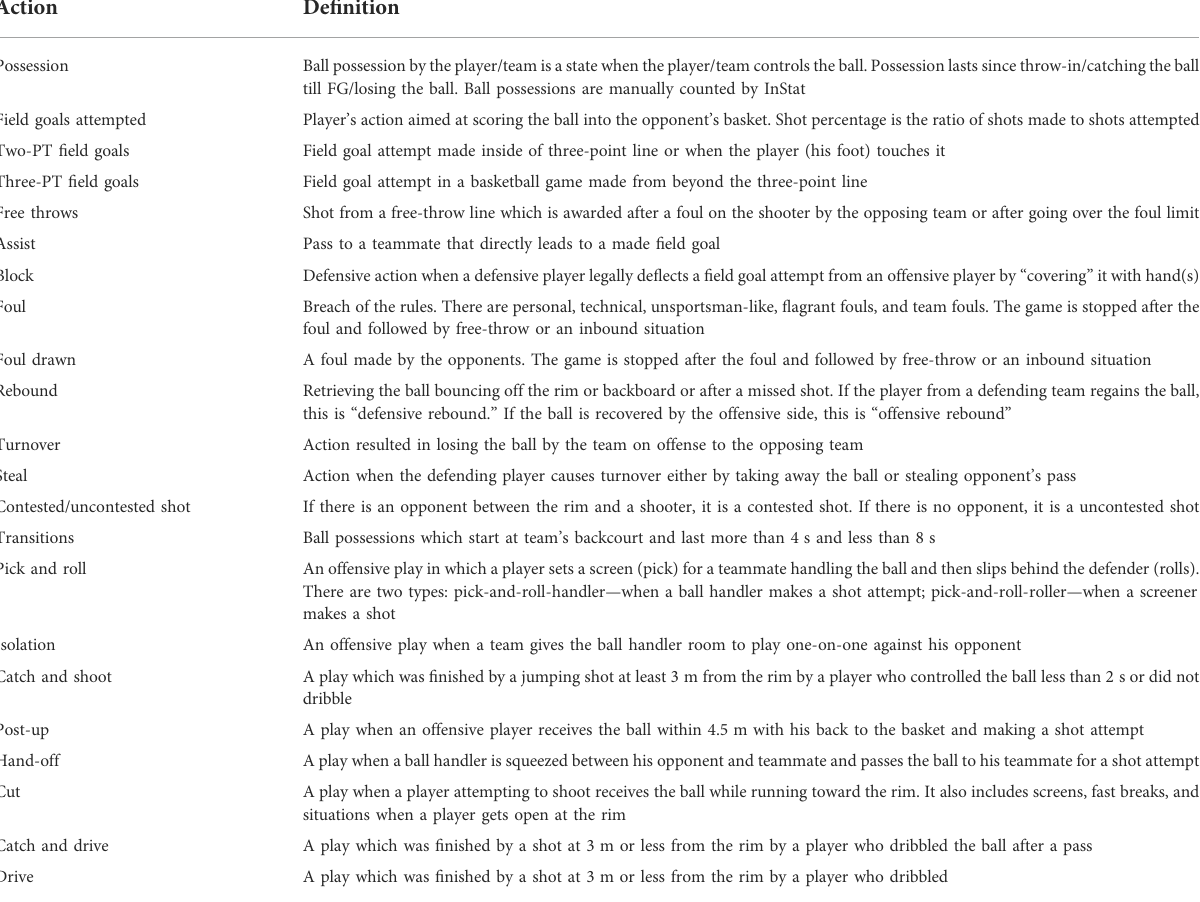
TABLE 1 Action de fi nitions by InStat. Action De fi nition